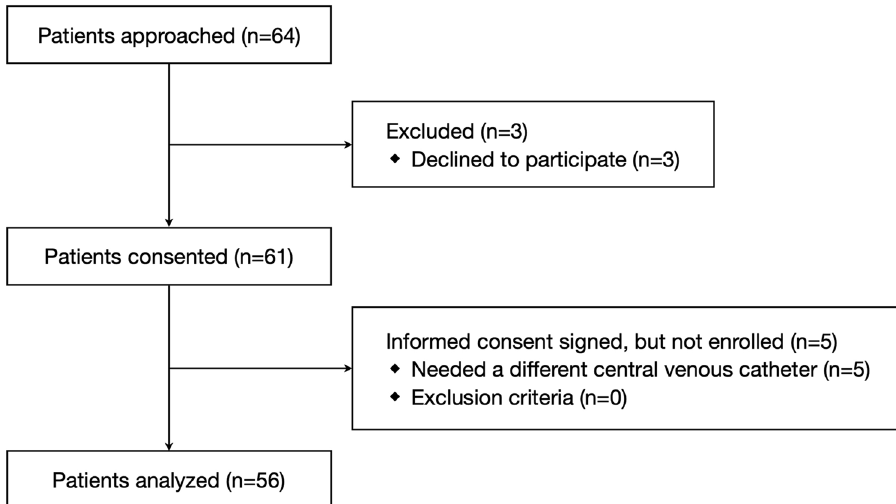
Figure 2. Patients flow diagram.